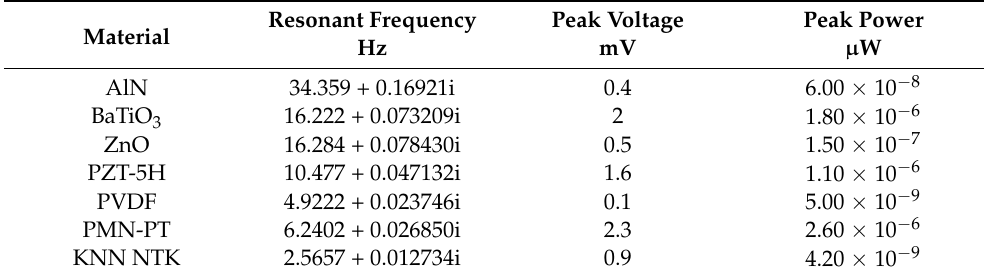
Table 2. The transverse vibration performance of the piezoelectric